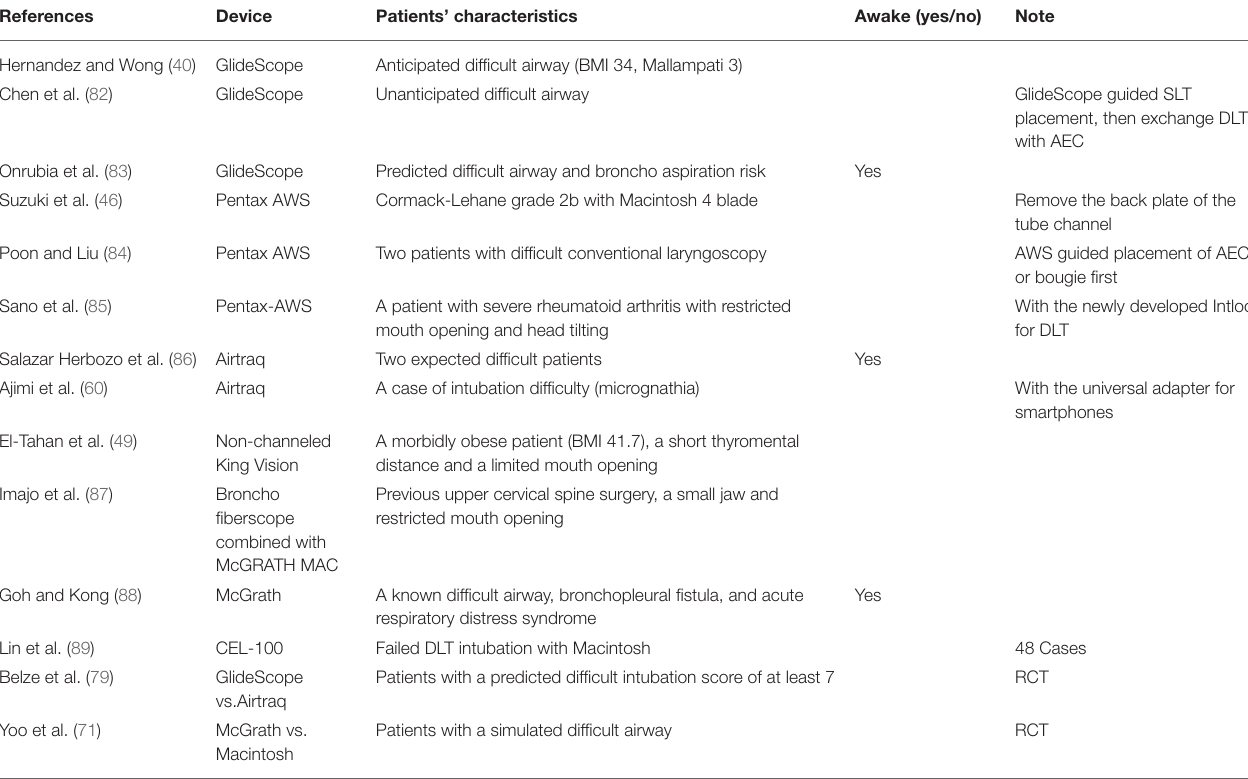
TABLE 3 | Videolaryngoscope-guided double lumen tube intubation in difficult